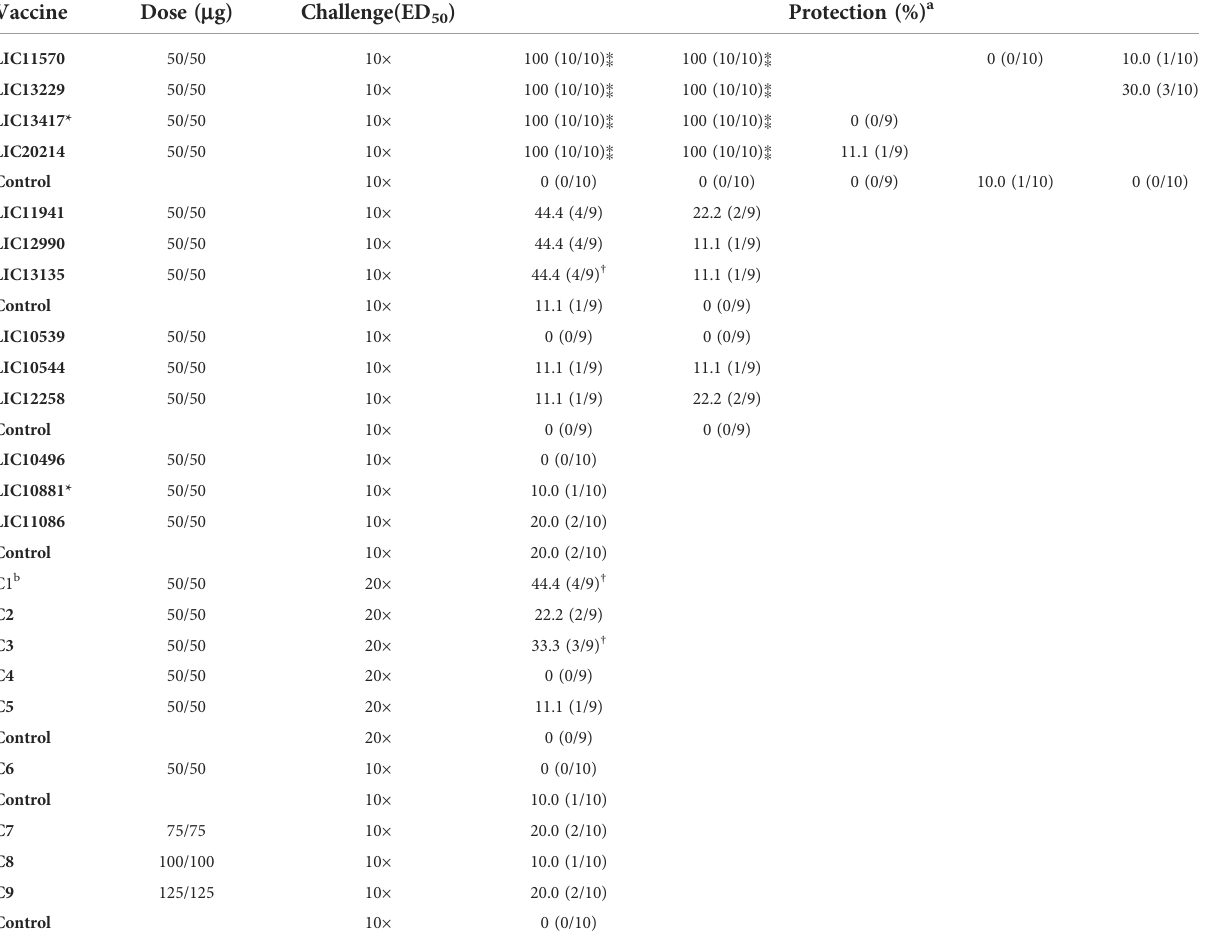
TABLE 2 Evaluation of the vaccine candidates in the hamster model of acute leptospirosis.